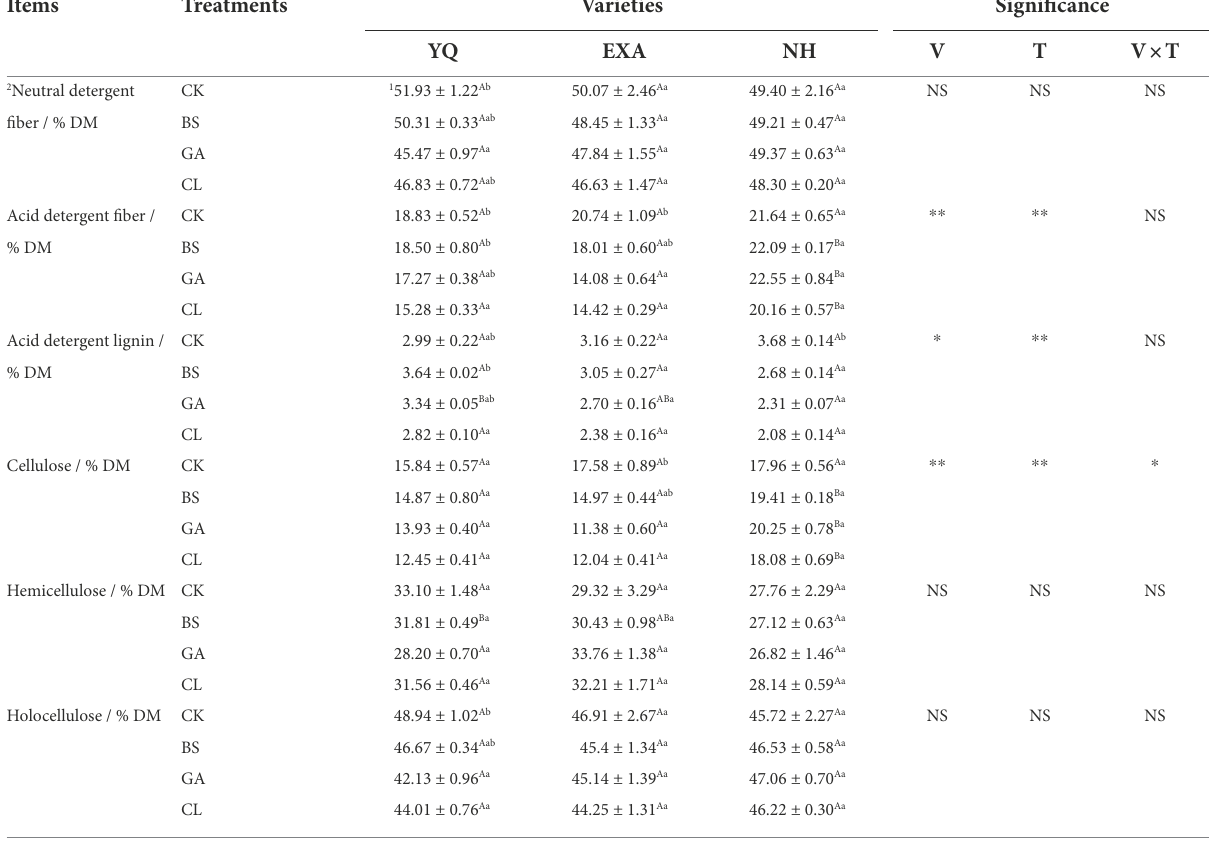
TABLE 3 Effects of varieties and additives on lignocellulosic compositions of whole-plant corn silage (±SD, n = 3). Items Treatments